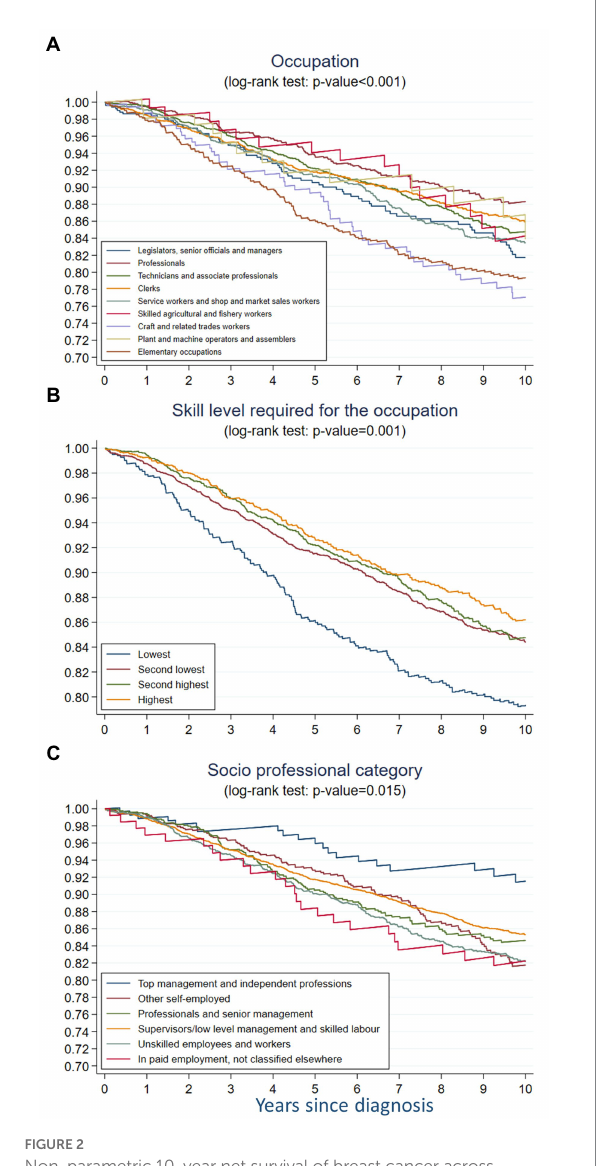
FIGURE 2 Non-parametric 10-year net survival of breast cancer across (A) occupation, (B) skill level required for the occupation, and (C) socio-professional category among women aged 18–85 in French-speaking Switzerland